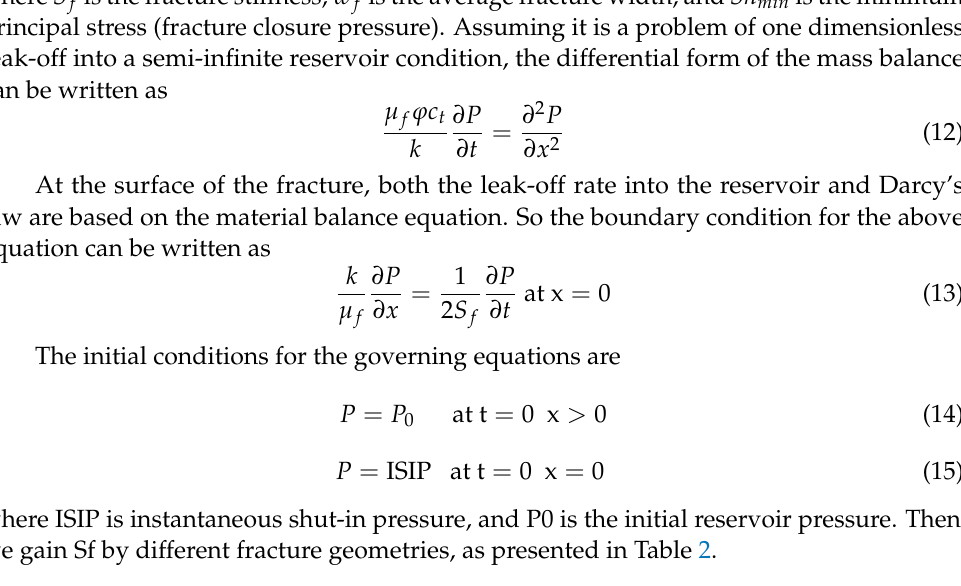
Table 2. Expression to calculate the Sf by three different fracture geometries [23]. Fracture Geometry PKN KGD Radial Fracture Stiffness Sf 2 E (cid:48)